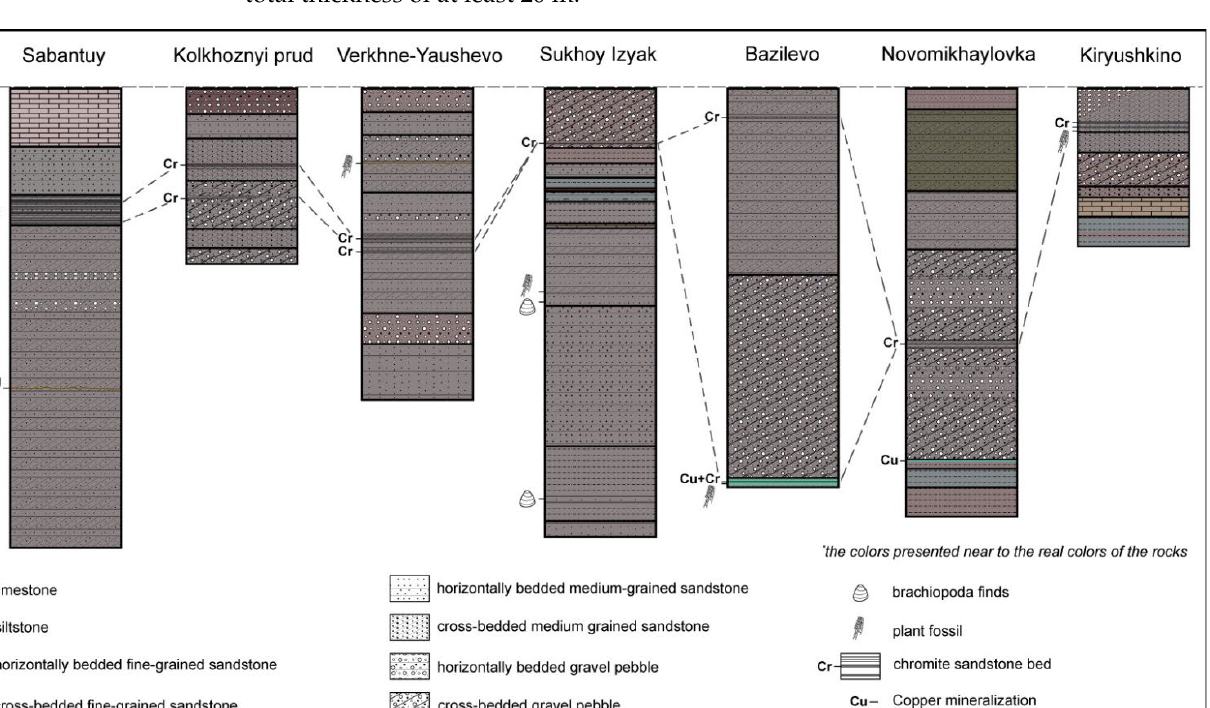
2–3 km west of the Sabantuy paleoplacer, bedded below are gray horizontally layered fine-grained sandstones with fragments of brachiopods and bluish gray siltstones with a total thickness of at least 20 m.